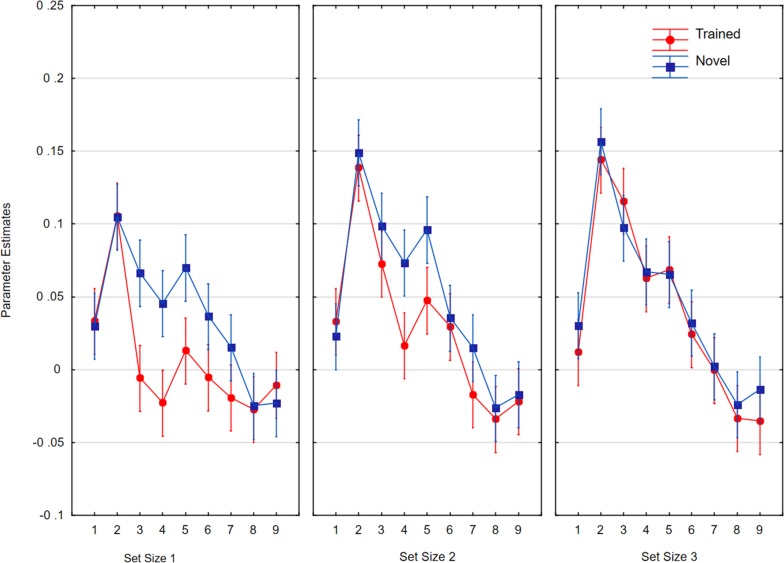
Parameter estimates for the fusiform cluster as a function of item status (trained, novel) and time point (TR1 to TR 9) for the three set sizes. Whiskers show within subjects confidence intervals based on the error term of the interaction according to Loftus and Masson (1994).